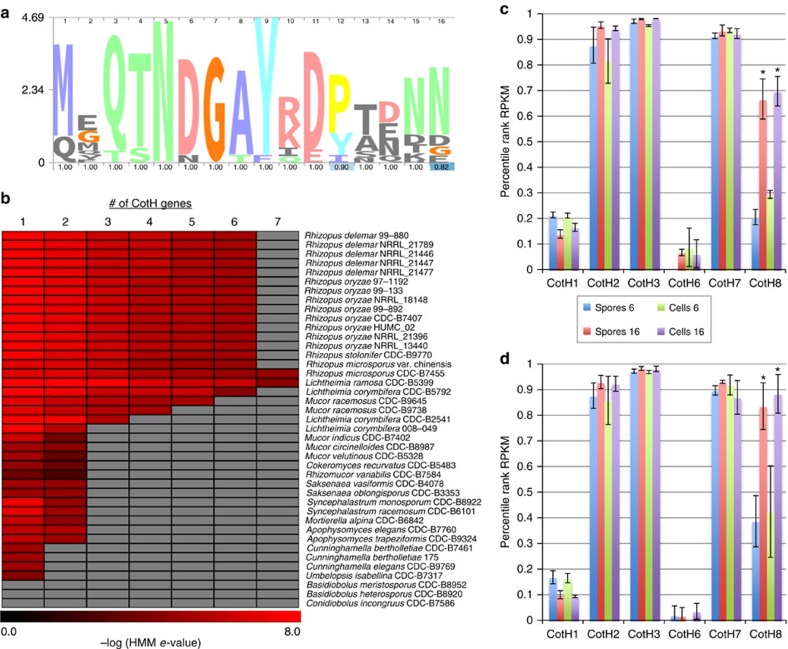
Presence of CotH invasins across Mucorales.(a) HMM logo depicting conserved invasin domain. (b) Presence of CotH3 domain containing proteins in all 41 Mucorales fungi. Values represent –log of the e value from an HMM search of each positive hit (maximum e value of 1 × 10−4) versus the motif from a. Grey colour indicates no gene. (c,d) Relative gene expression levels (expressed as percentile rank RPKM for all of the genes in the genome) for the six CotH genes of R. delemar 99-880 (c) and R. oryzae 99-892 (d) during in vitro infection conditions. Blue and red bars indicate spores grown alone in tissue culture media for 6 h (blue) or 16 h (red). Green and purple bars indicate spores grown exposed to airway epithelial cells for 6 h (green) or 16 h (purple). Results are the mean±s.d. *P<0.05 versus 6-h sample in the same condition; n=3. Gene of the same name in R. delemar 99-880 and R. oryzae 99-892 represent 1-to-1 homologues.